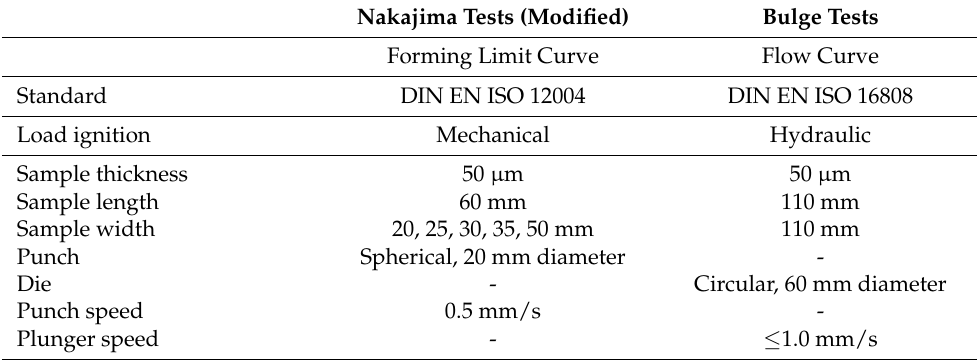
Table 1. Comparison of test parameters—Nakajima Tests and Bulge Tests.